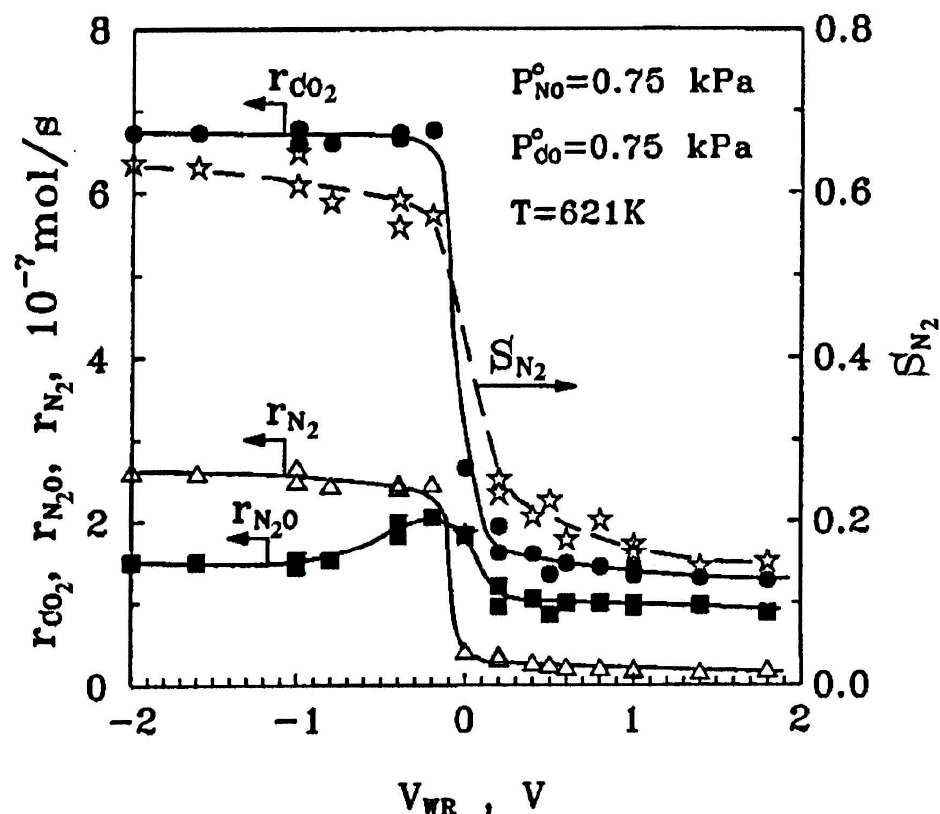
Figure 9. Effect of catalyst potential on the CO 2 , N 2 and N 2 O formation rates and the selectivity towards N 2 during the EPOC by Na of the Pt-catalysed NO + CO reaction. Conditions: [NO] = [CO] = 0.75%, T = 348 ◦ C. Data was acquired in a Pt/(Na) β ”Al 2 O 3 /Au galvanic cell. (Reprinted with permission from Ref. [17]; Copyright 2005, Elsevier).